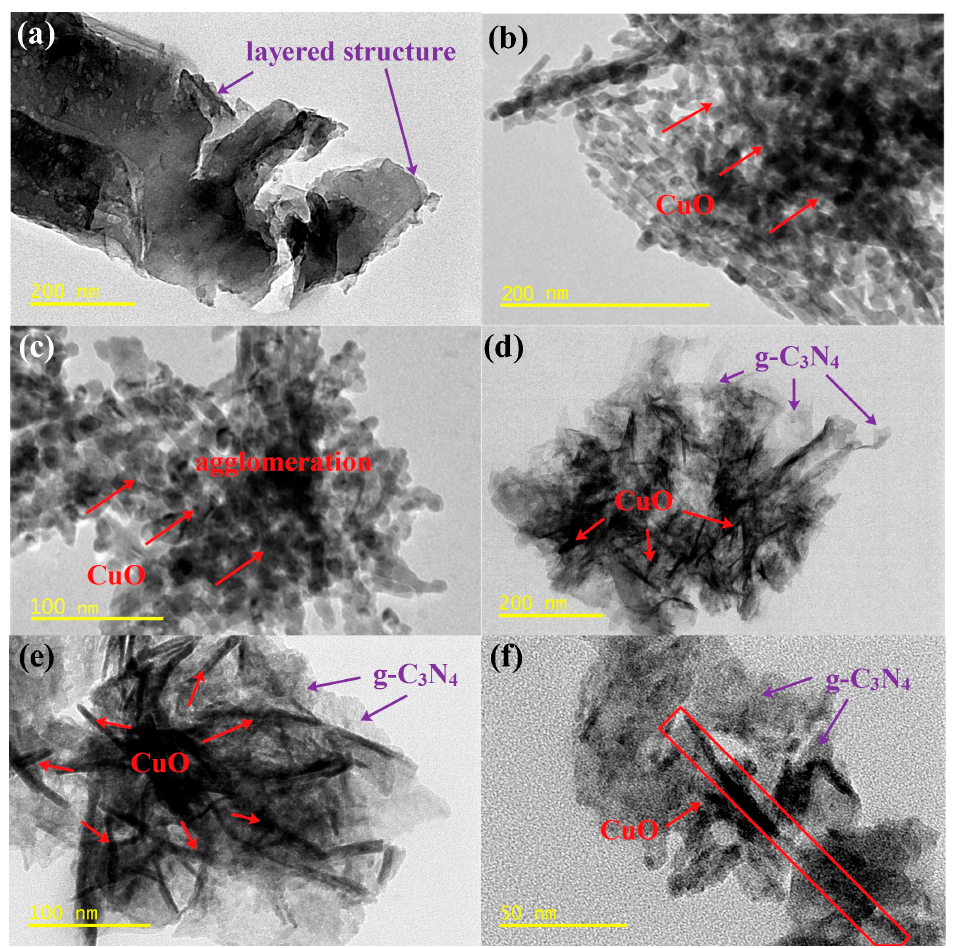
Figure 2. Transmission electron microscopy (TEM) images of ( a ) pure g-C 3 N 4 , ( b , c ) CuO, and ( d – f ) g-C 3 N 4 /20 wt % CuO